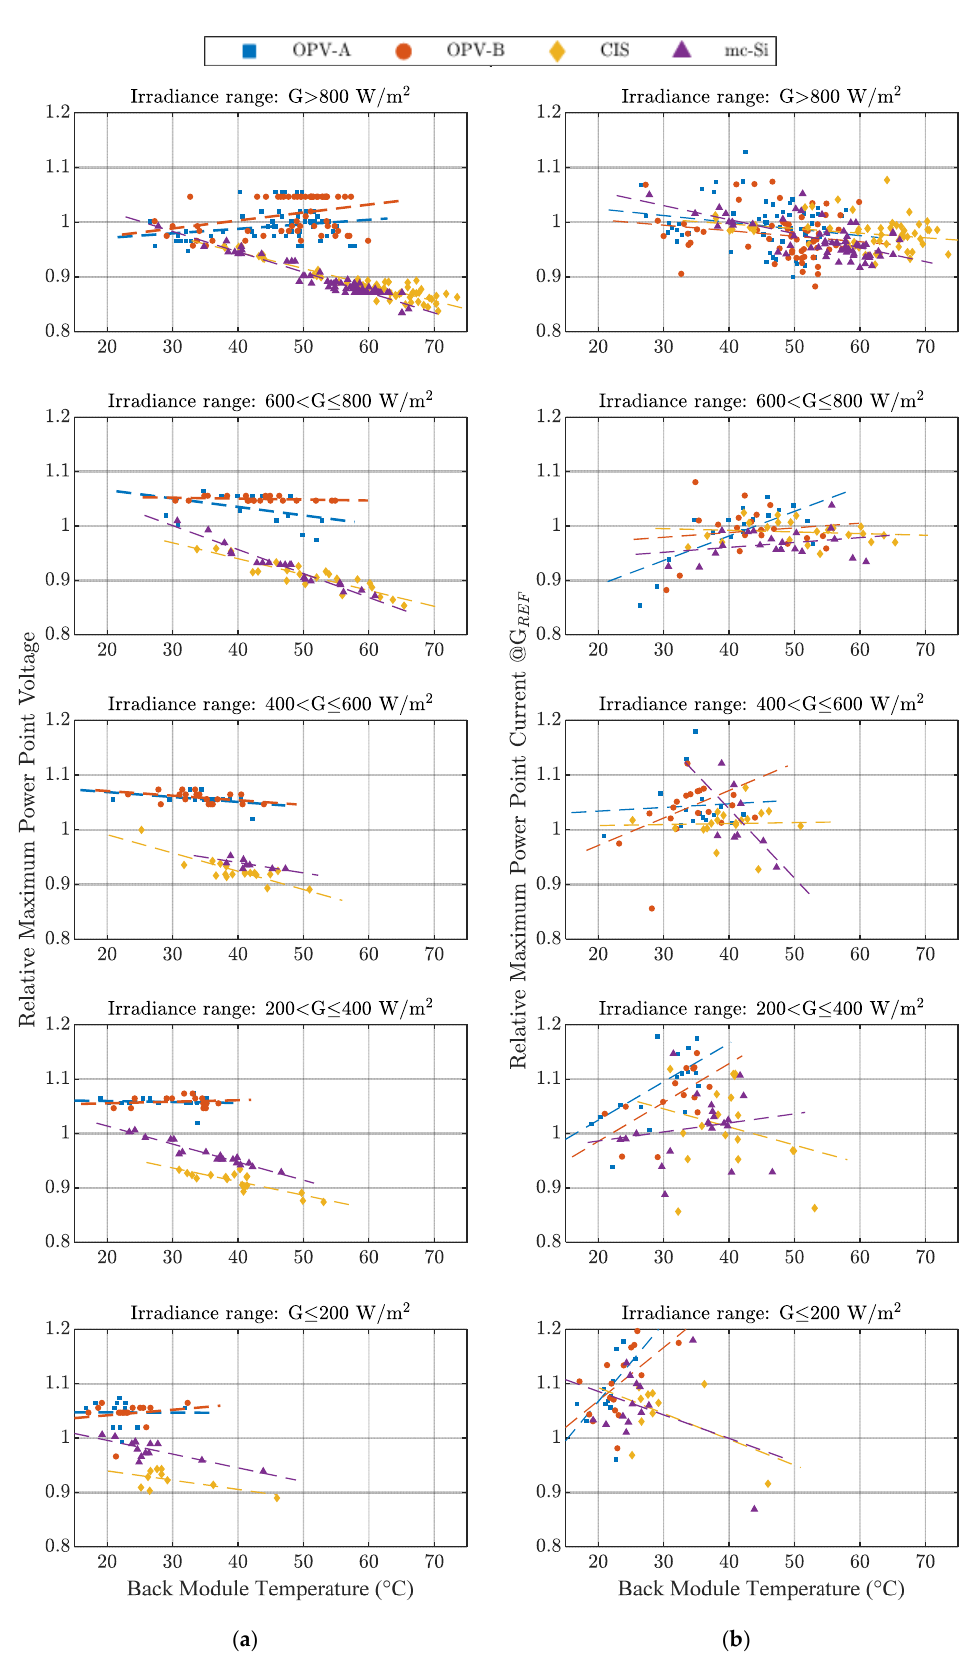
Figure 6. Relative maximum power point voltage ( a ) and relative maximum power point current ( b ) as a function of the back module temperature for the whole set of PV modules under test.